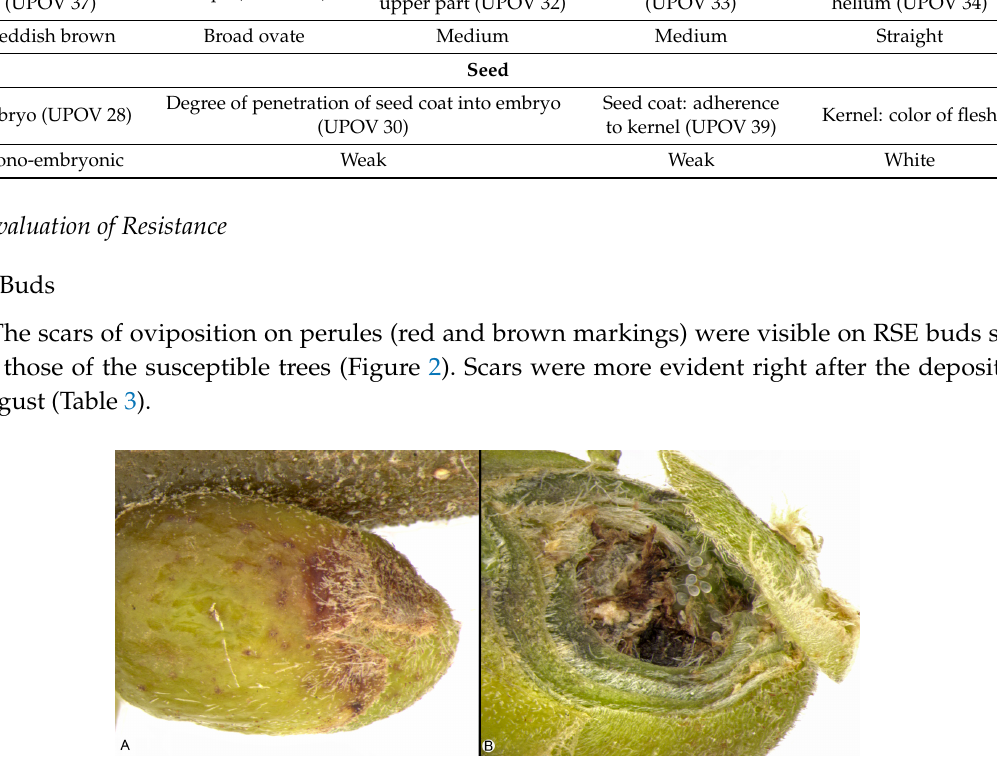
Table 2. Main carpometric characteristics of the fruits observed ( n = 50) according to the International Union for the Protection of New Varieties of Plants (UPOV) [33].